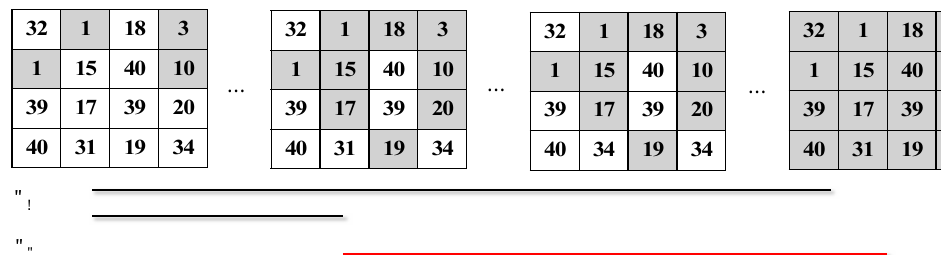
Figure 4. A greyscale image patch and its corresponding cubical complex filtration and persistent barcode representation in dimension zero and one. B 0 and B 1 represent Betti numbers in dimension zero and one, respectively.